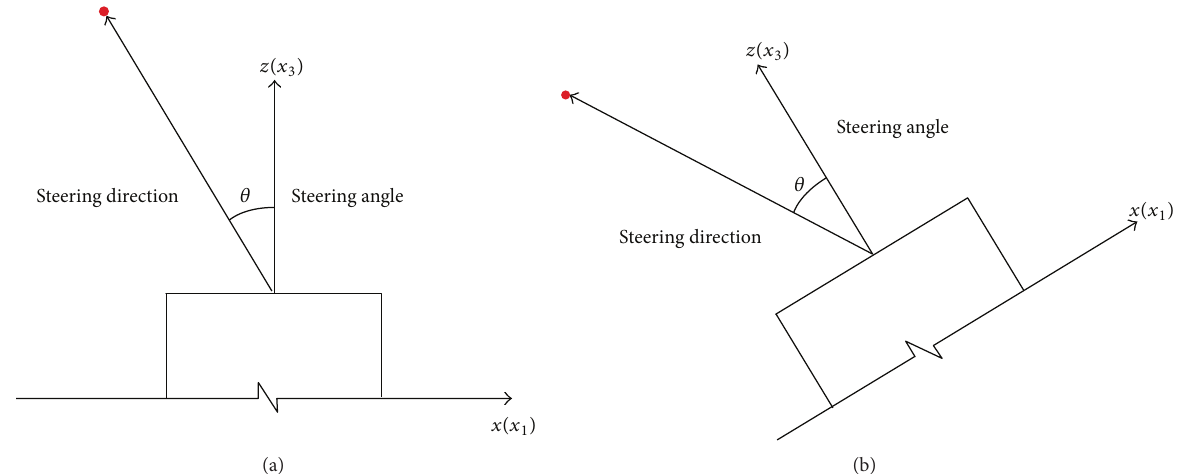
Figure 8: (a) A steering angle of a phased array transducer. (b) A conventional transducer rotated at an angle.